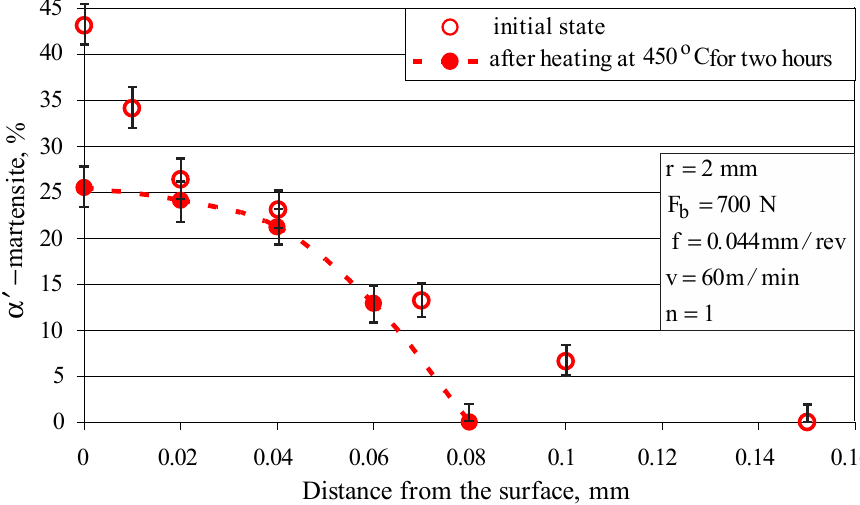
Figure 19. Residual stress relaxation due to heating (at 450 (cid:2925) C for two hours): ( a ). austenitic phase; ( b ). martensitic phase. FSI is significantly increased in the HCF field for the following reasons: (1) The bending stresses are lower, as a result of which the relaxation of the compressive residual stresses is less pronounced; (2) DB causes strain hardening of the surface and subsurface layers, i.e., the yield limit of these layers increases, and as a result, the bending stresses are in the elastic field; (3) Less pronounced reverse martensitic transformation γα →′